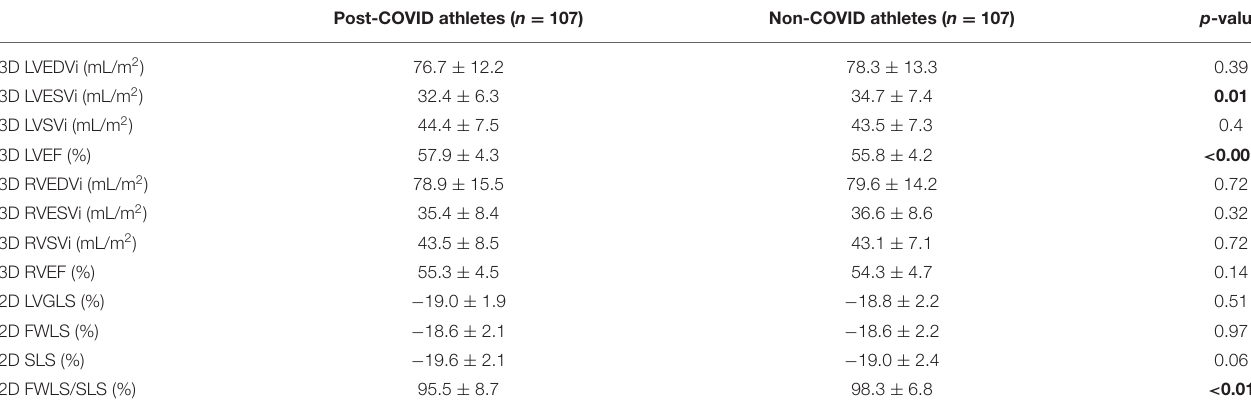
TABLE 3 | Comparison of 3D and speckle-tracking echocardiographic data between the post-COVID and the non-COVID athlete